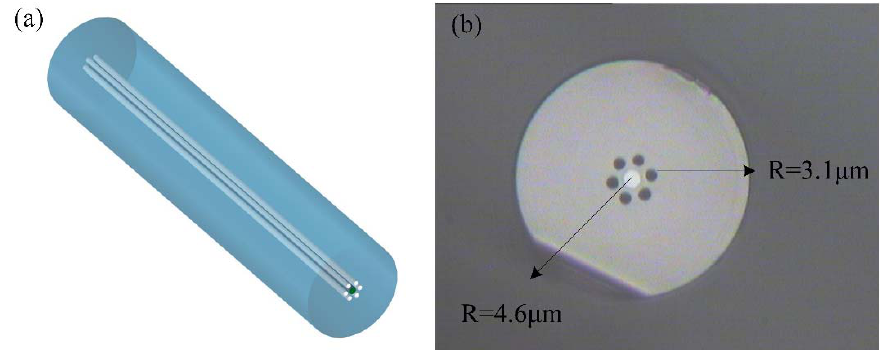
Figure 1. ( a ) Structural diagram of SCSHF; ( b ) cross-section of SCSHF under a microscope.